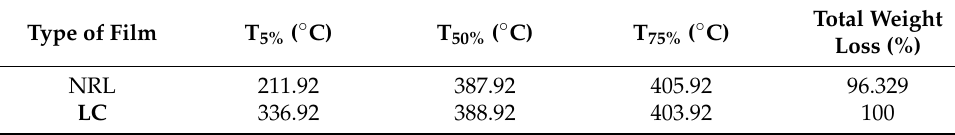
Figure 7. ( a )TGA and ( b ) derivative thermogravimetry (DTG) curves of NRL and LC . Figure 7. ( a ) TGA and ( b ) derivative thermogravimetry (DTG) curves of NRL and LC . Table 5. The thermal stability comparison of NRL and LC . Table 5. The thermal stability comparison of NRL and LC